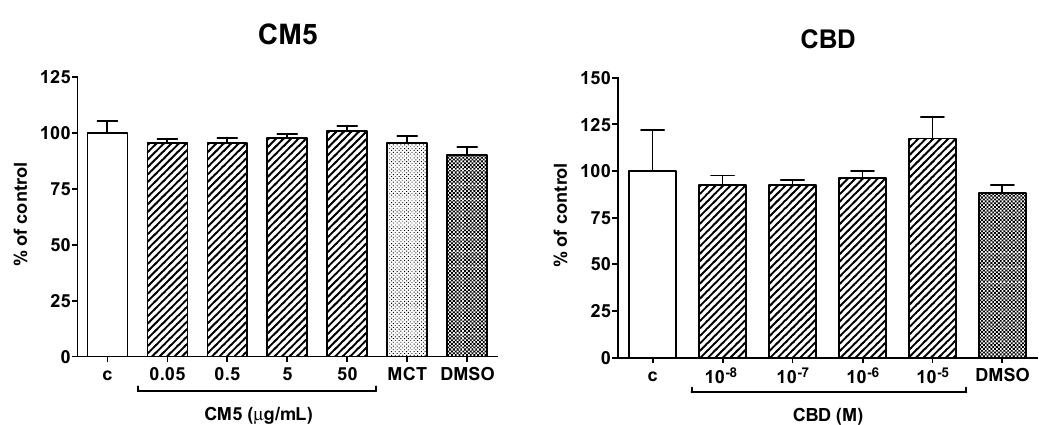
Figure 2. Effect of CM5 and cannabidiol (CBD) and of their respective mediums, medium chain triglycerides (MCT) and dimethylsulfoxide (DMSO), on polymorphonuclear leukocytes (PMN) viability. PMN were cultured for 21 h alone or in the presence of the test substances at the indicated concentrations. MCT and DMSO were added at concentrations equivalent to those contained in CM5 50 µ g / mL and in CBD 10 µ M, respectively. Each column is the mean ± SEM of 5 separate preparations in duplicate. c = control.